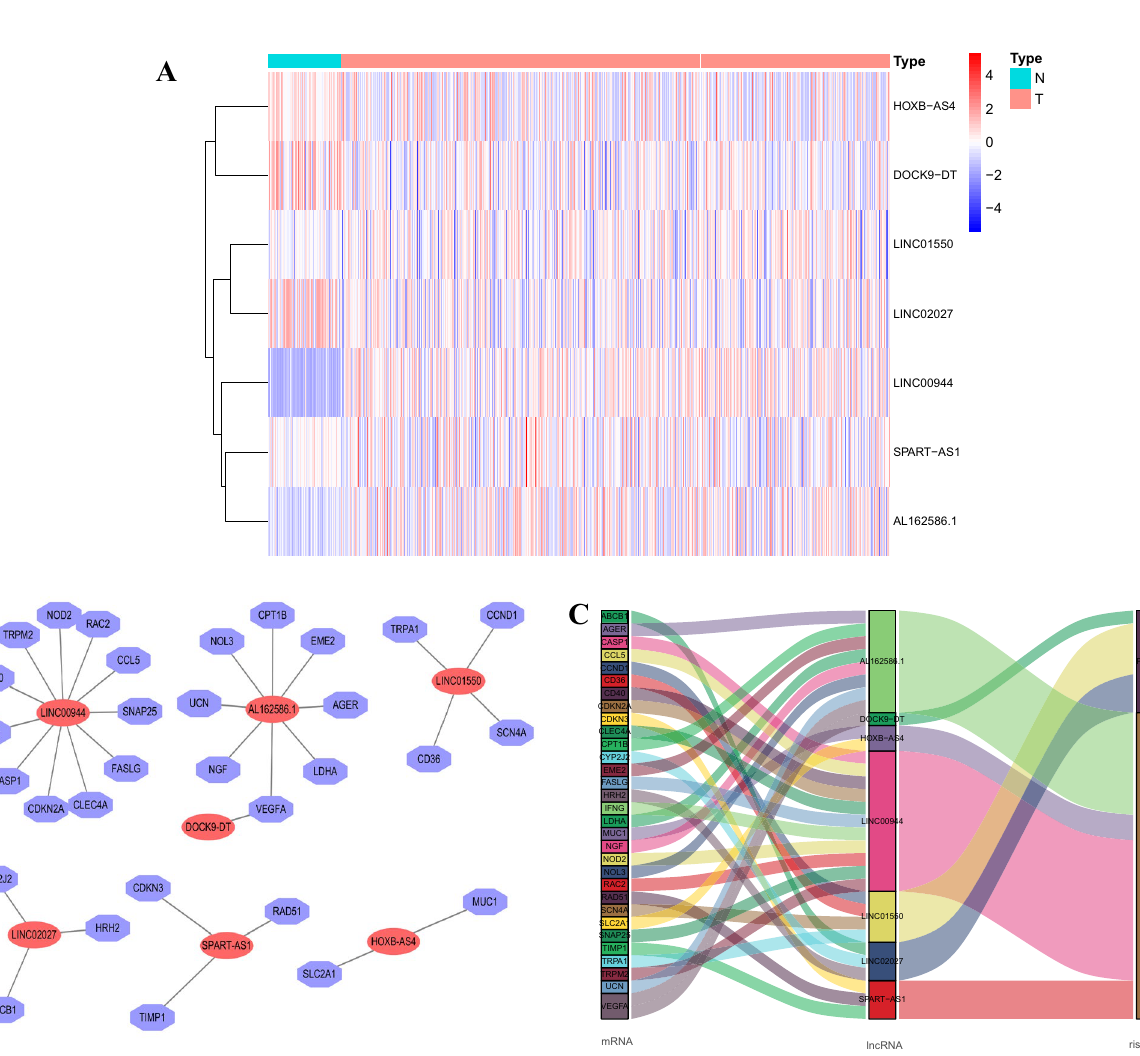
Figure 2. Expression and lncRNA–mRNA network of seven OS-related lncRNAs in the predictive signature. ( A ) Expression of seven OS-related lncRNAs in ccRCC and normal tissues. ( B ) The co-expression network of prognostic OS-related lncRNAs. ( C ) Sankey diagram of prognostic OS-based lncRNAs. lncRNAs, long non- coding RNAs; ccRCC, clear cell renal cell carcinoma; N, normal; T,